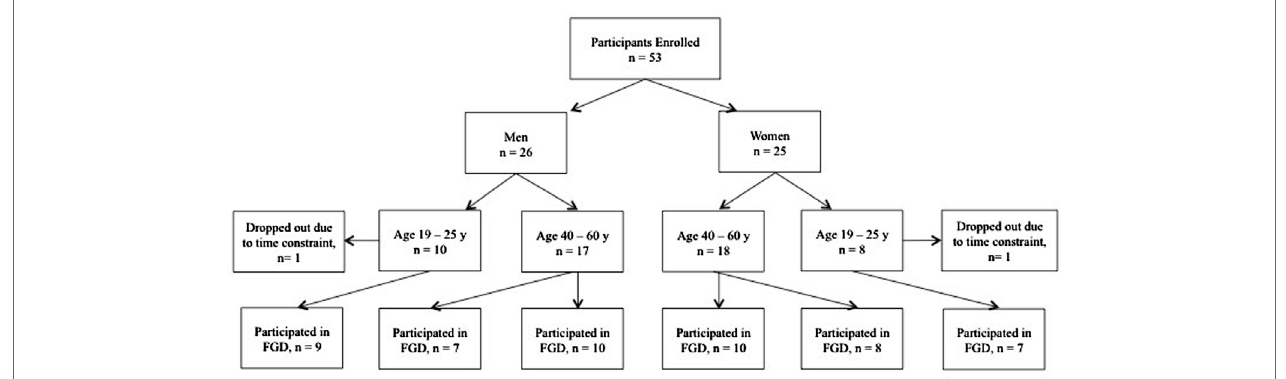
FigUre 1 | Participants distribution by gender and